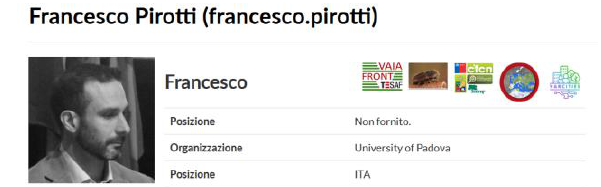
Figure 7. Single user with profile of relative projects and